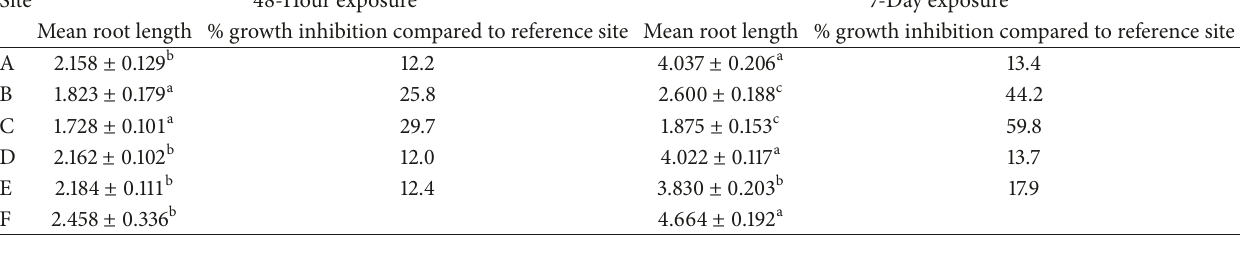
Table 4: The spatial variation of root lengths and percentage root growth inhibition of A. cepa bulbs exposed to sediment elutriate samples collected from study sites. Data are presented as mean ± SD. Results indicated by different superscript letters in each column are significantly different from each other (ANOVA, Tukey’s test, p < 0.05, n=5).